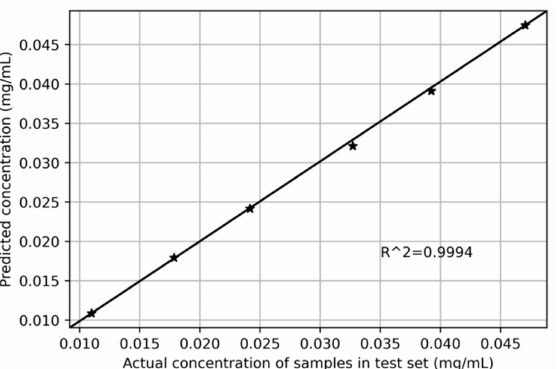
Figure 7. Content prediction results of test set based on UV6300 spectrophotometer.